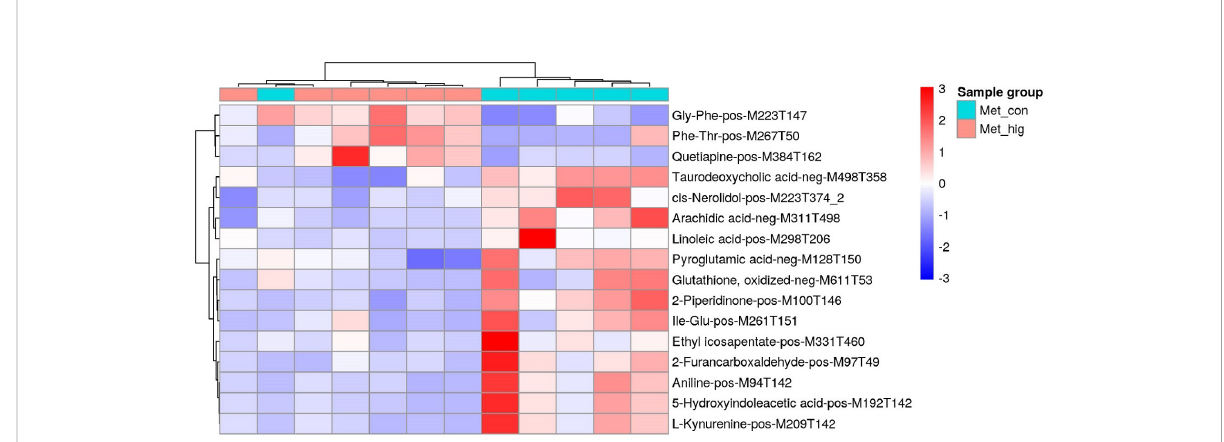
FIGURE 5 Heatmap of identi fi ed secondary metabolites showing signi fi cant difference between MeHg treatment and the control groups in the liver tissues of juvenile fl